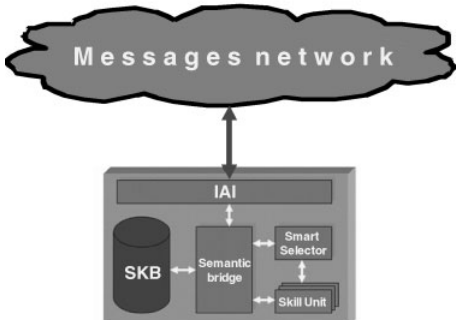
Figure 2 The common agent structure (CAS). All the agents in MARCA are designed using this structure. The number of skill units contained into each agent is variable, and it depends on the agent’s functionality as well as on the human and robot capabilities provided by the